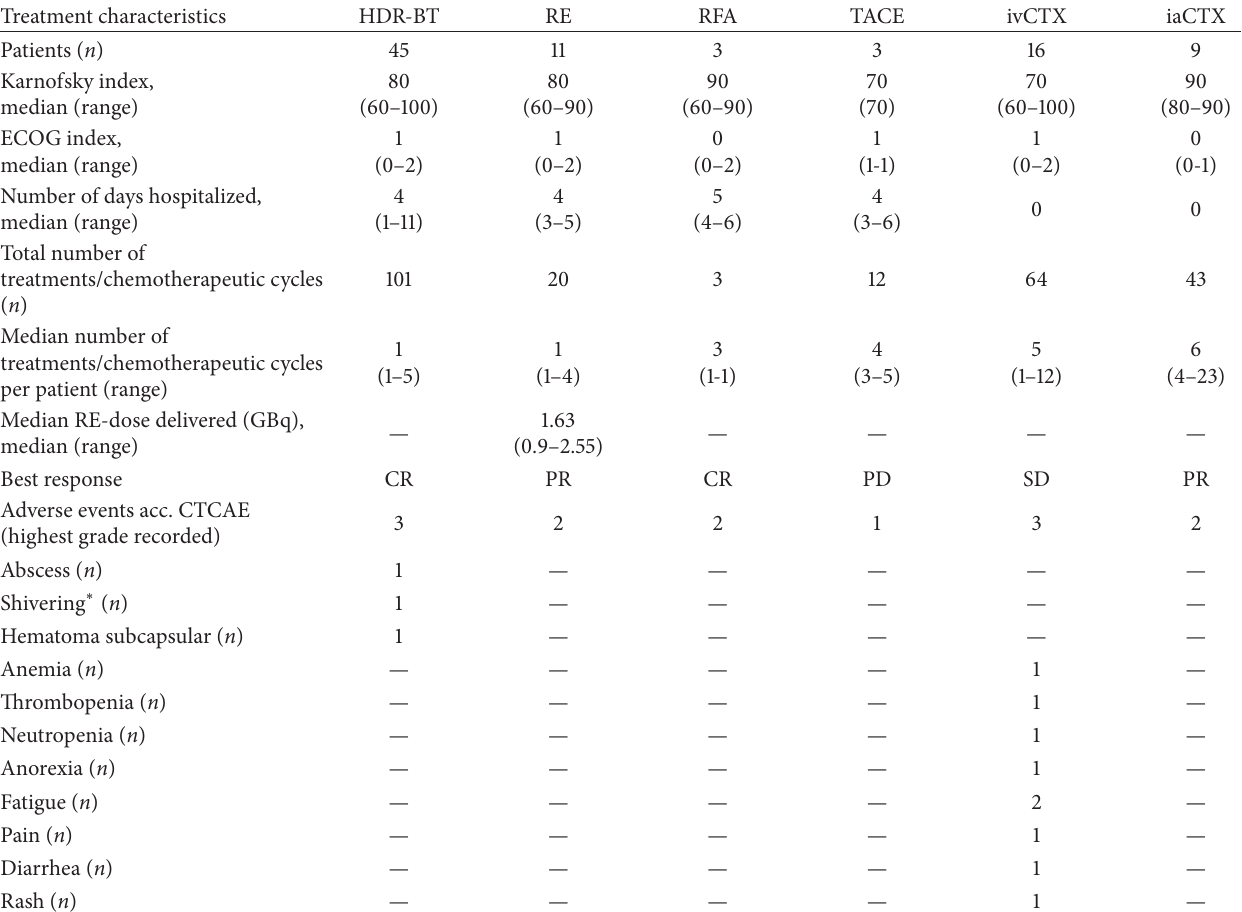
Table 2: Treatment characteristics and cumulative toxicities analysis: only Grade 3-4 toxicities are reported (CTCAE version 4.0). Treatment